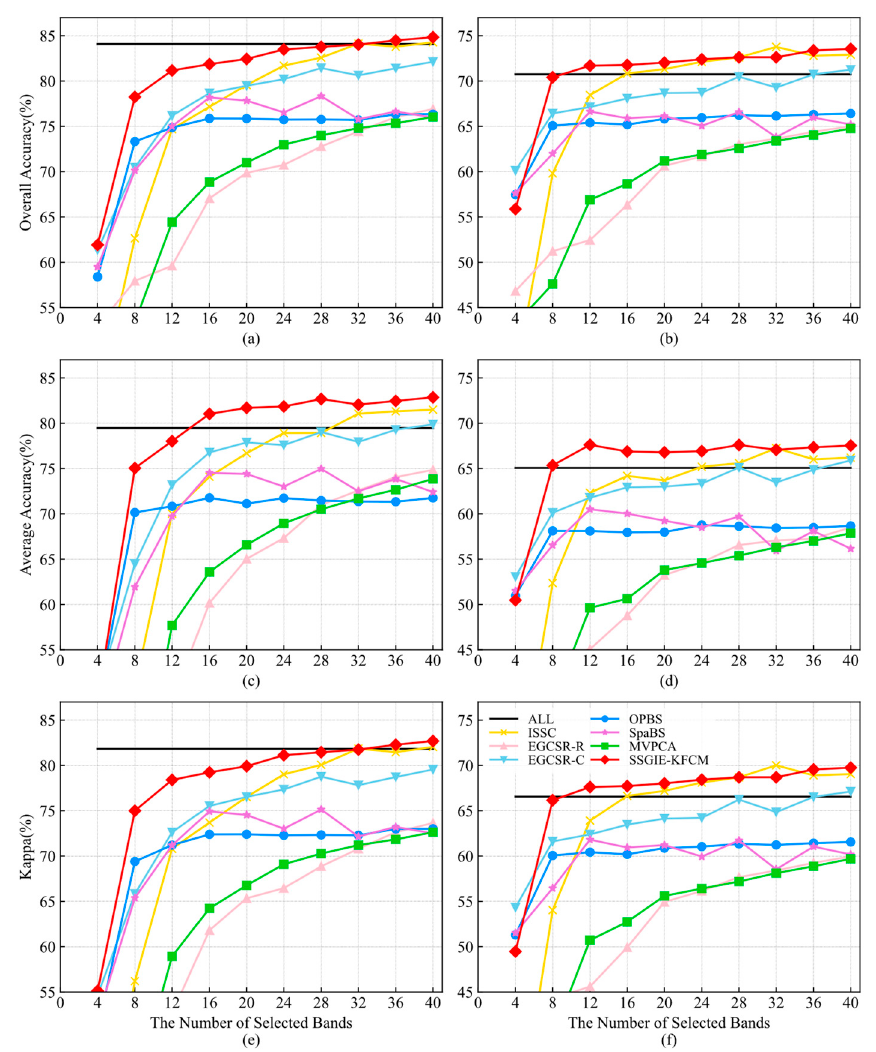
Figure 6. Classification accuracy of different band selection methods using the Indian Pines dataset with different band subset sizes. ( a , c , e ) are SVM classifiers; ( b , d , f ) are KNN classifiers.